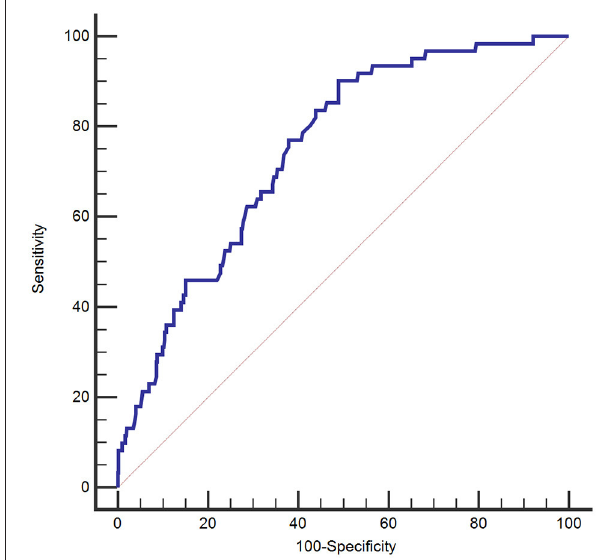
FIGURE 3 | Receiver operating characteristic curve of the plasma glucose to potassium ratio for 3-month mortality of patients with aneurysmal subarachnoid hemorrhage.